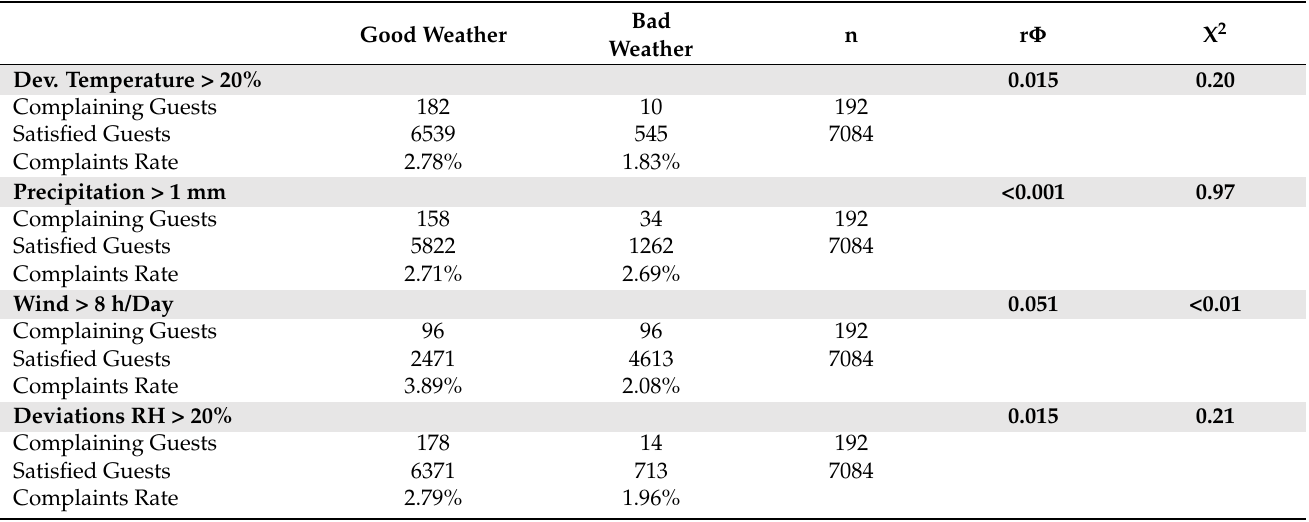
Table 4. Results of correlation analysis for the relationship between temperature, precipitation, wind speed or relative humidity and